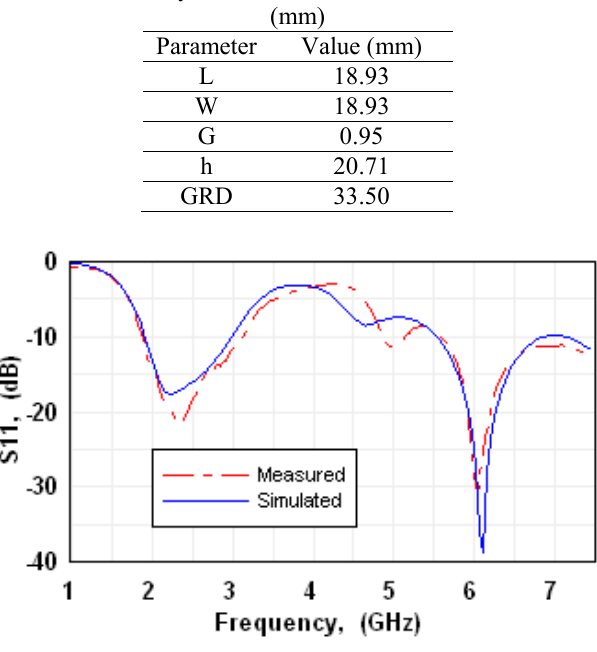
Figure 13. Photos of the fabricated antenna prototype; (a) the top view and (b) the bottom view. Table 2. Summary of the fabricated antenna dimensions in